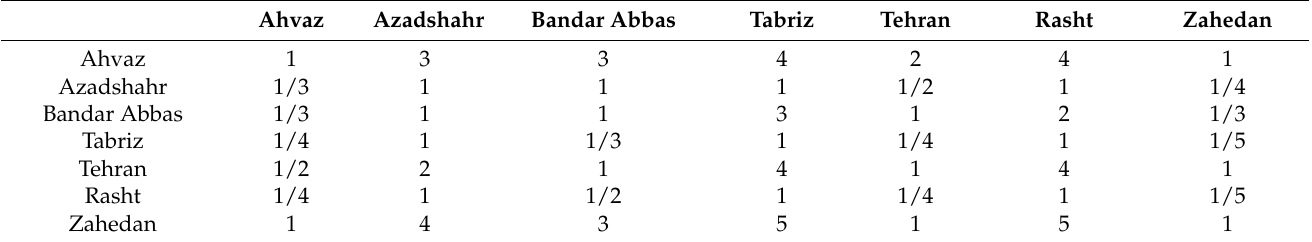
Table 6. Pairwise comparison matrix of alternatives with respect to EPBP.